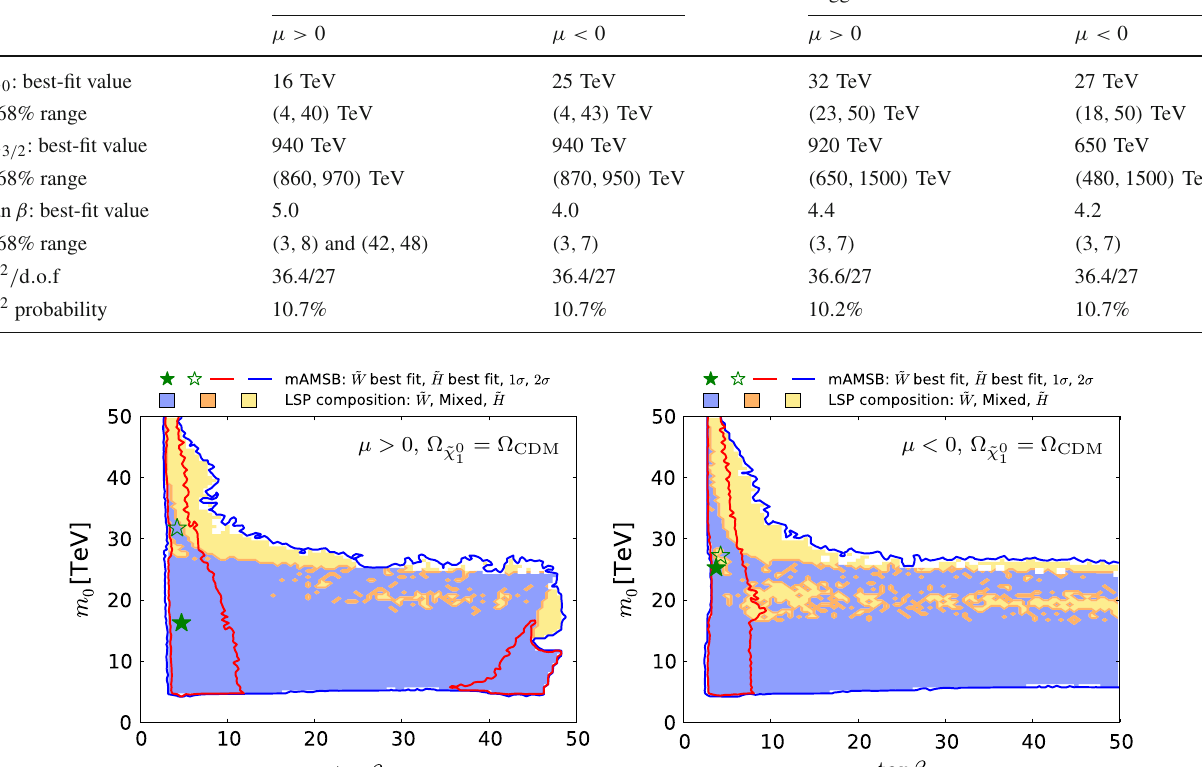
Fig. 6 The ( tan β, m 0 ) planes for μ > 0 ( left panel ) and for μ < 0 ( right panel ), assuming that the ˜ χ 0 convention for the shadings and contours is the same as in Fig. 4, and the best-fit points for the two signs of μ are again indicated by green